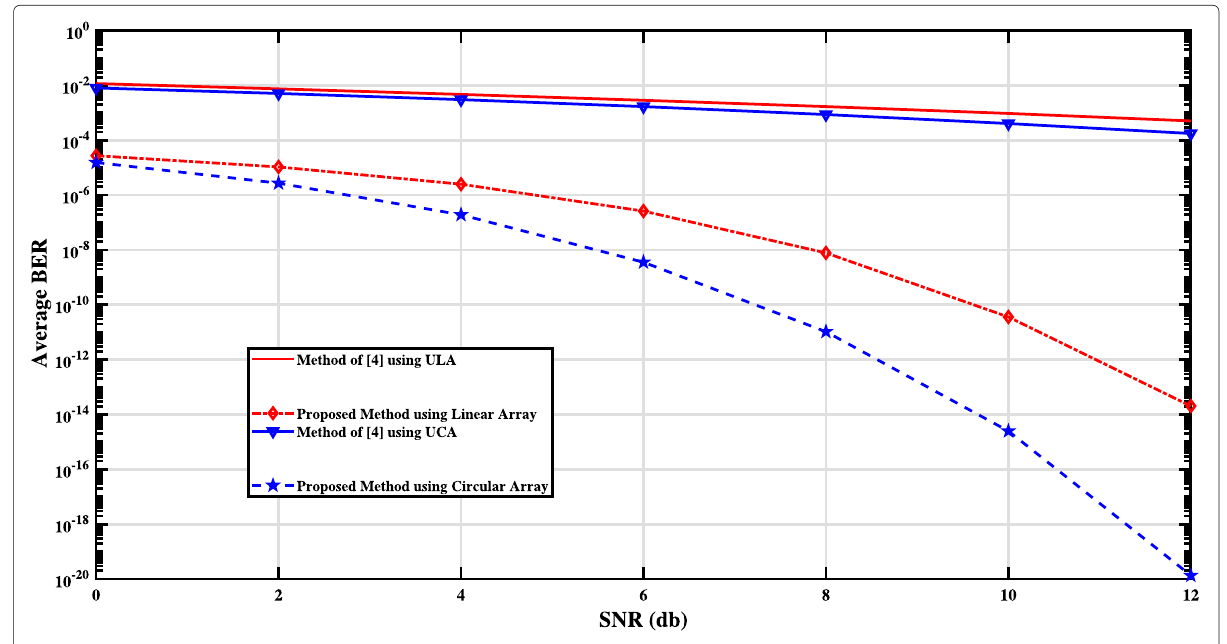
Fig. 7 Average BER performance versus SNR for Example 2 with N B = 32 and N U =